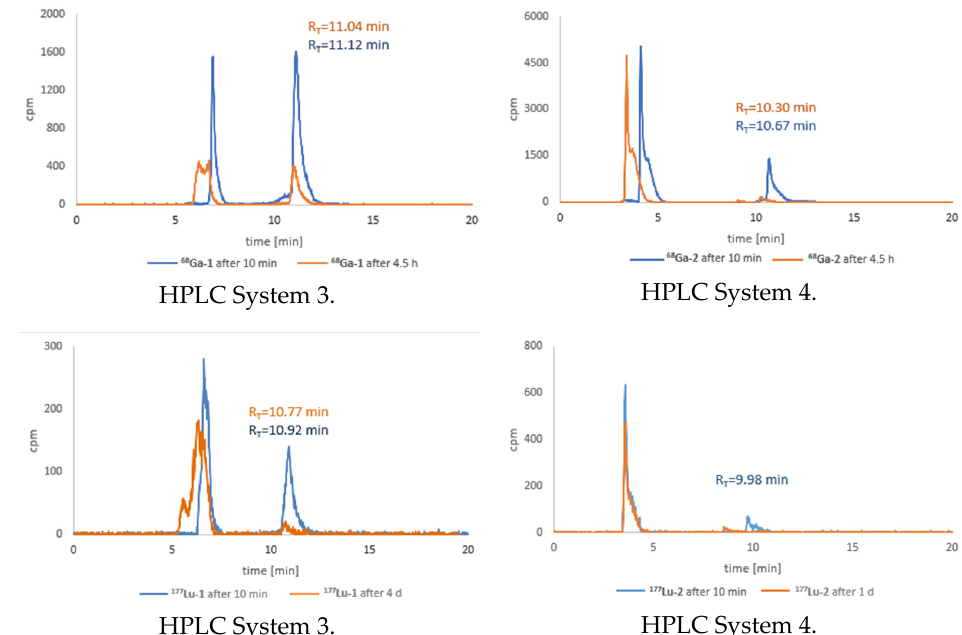
Figure 8. RP-HPLC radiochromatograms illustrating the results of the stability tests of the 68 Ga-1 and 177 Lu-1 ( left , System 3) and 68 Ga-2 , 177 Lu-2 ( right , System 4) radioconjugates in human serum recorded after different time intervals. Table 5. Statistical data of the 68 Ga-1 , 177 Lu-1 , 68 Ga-2 , and 177 Lu-2 radioconjugates radiochemical purity corresponding to the radiochromatograms presented in Figure